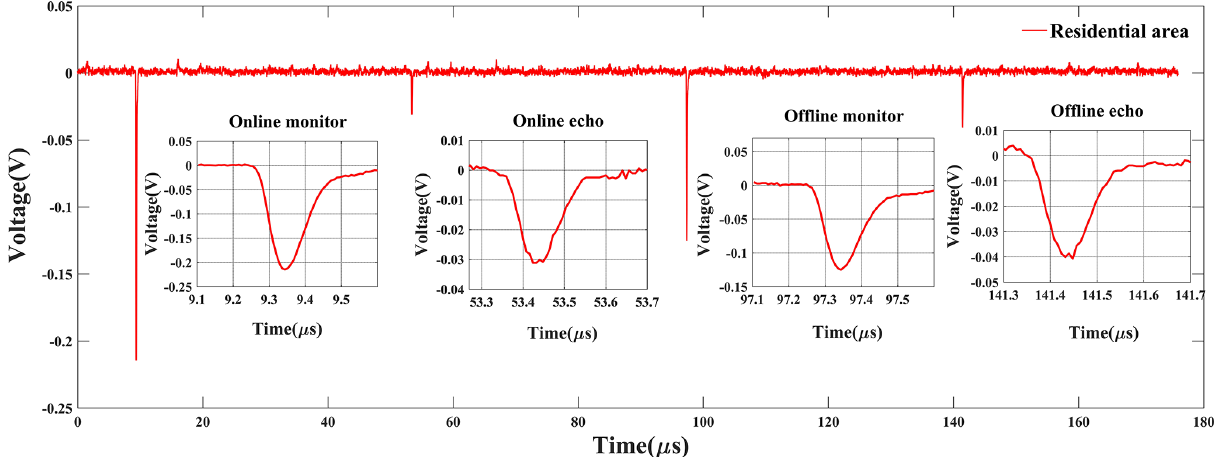
Figure 5. Original echo signal of urban residential area (total signal and pulse amplification signal). The amplification signals from left to right are online monitor signal, online echo signal, offline monitor signal, and offline echo